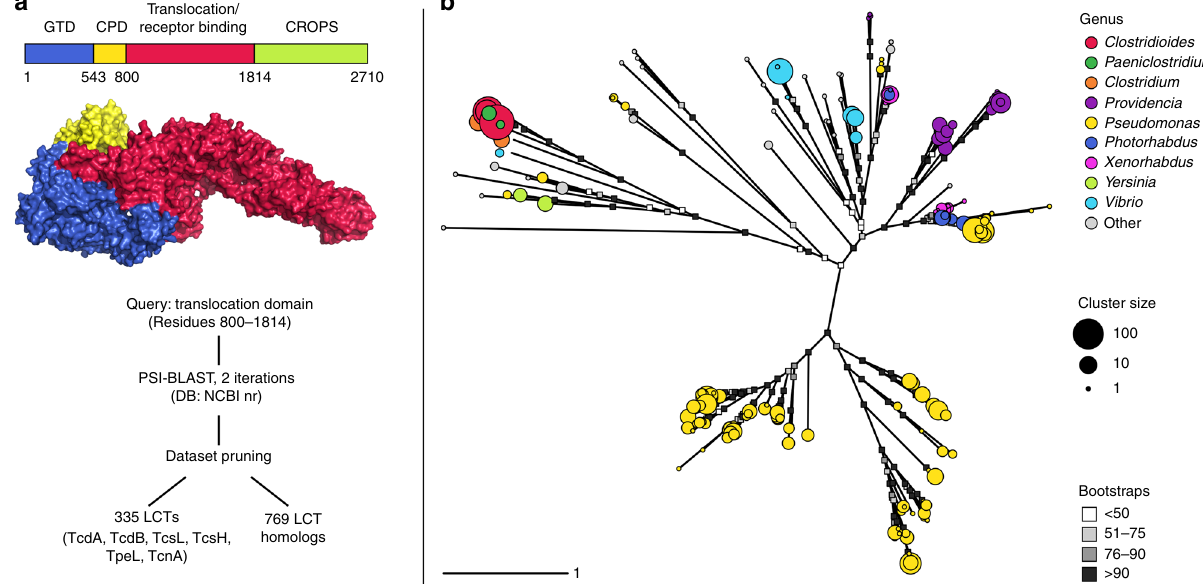
Fig. 1 Discovery of LCT-like translocases in diverse species. a The search strategy for discovering proteins with LCT-like translocases began by searching the NCBI non-redundant protein database (NR) using the TcdB T-domain as a query (UniProt P18177.3), followed by two iterations of PSI-BLAST searches. After removal of partial and poorly aligning sequences, a total of 1104 LCT and LCT-T homologs were retrieved. b A redundancy-removed and pruned alignment of translocase sequences was used to generate a maximum likelihood phylogeny. Each tip represents a sequence cluster centroid and colored according to their genus (genera that represent more than 1% of the total dataset are colored. Tip radius is proportional to the size of the